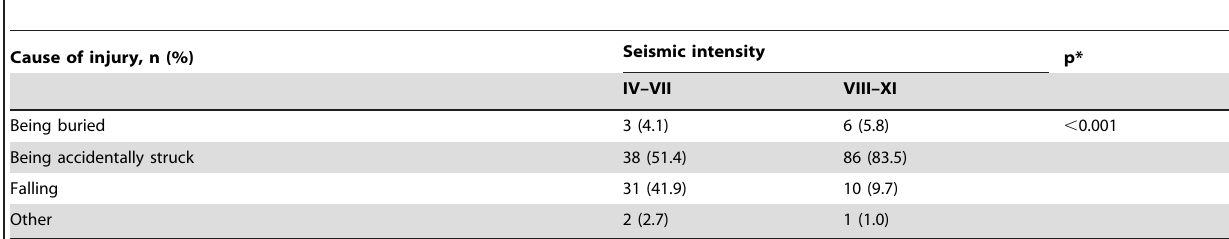
Table 4. Relationships between seismic intensity and cause of injury in patients admitted to our hospital after the Wenchuan and Lushan